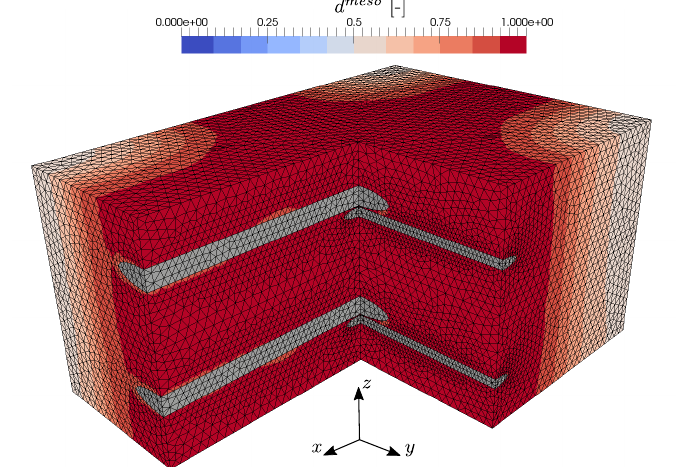
Figure 16. Evolved effective mesoscopic damage distribution due to biaxial tensile loading with prescribed strain ¯ (cid:101) = [ ¯ (cid:101) xx = ¯ (cid:101) bt , ¯ (cid:101) yy = ¯ (cid:101) bt , ¯ γ xy = 0 ]